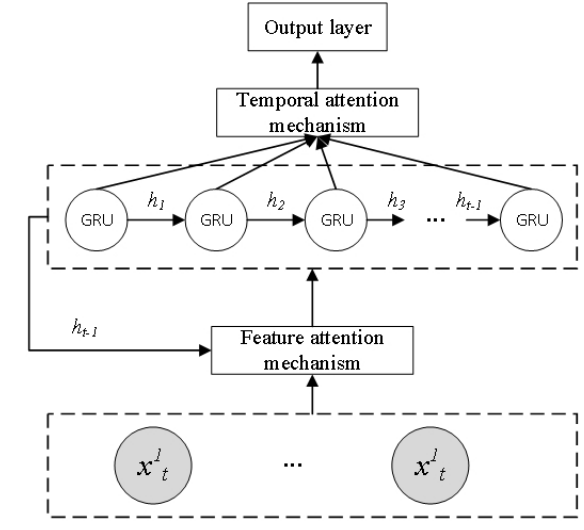
Fig. 6. Structure of dual attention mechanism-based